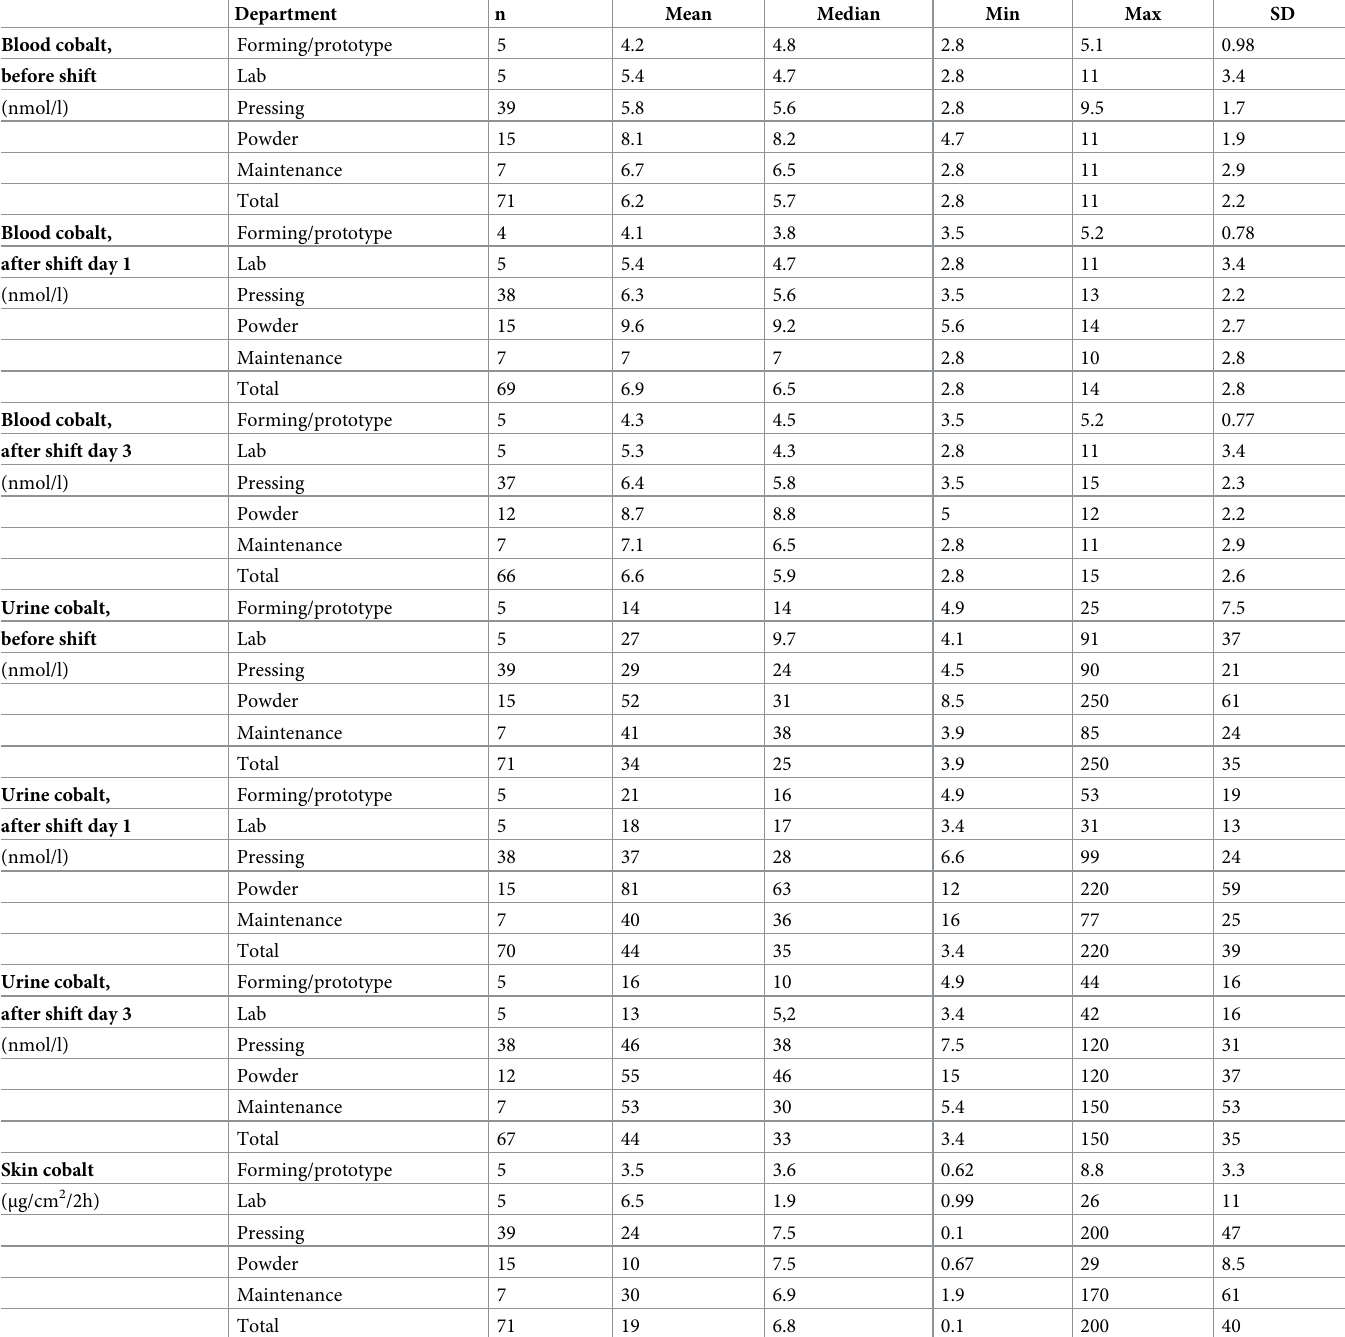
Table 4. Concentration levels cobalt in blood and urine and cobalt on skin by job